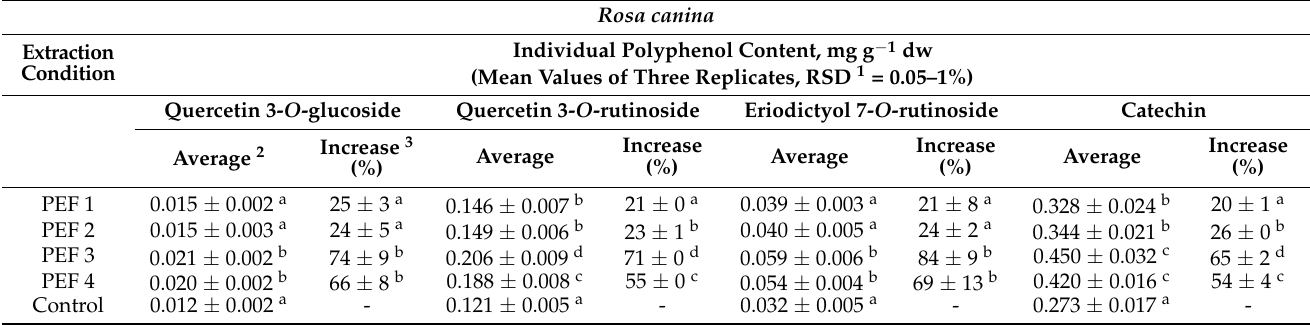
Table 2. Identified polyphenolic compounds of Rosa canina (fruits) extracts.